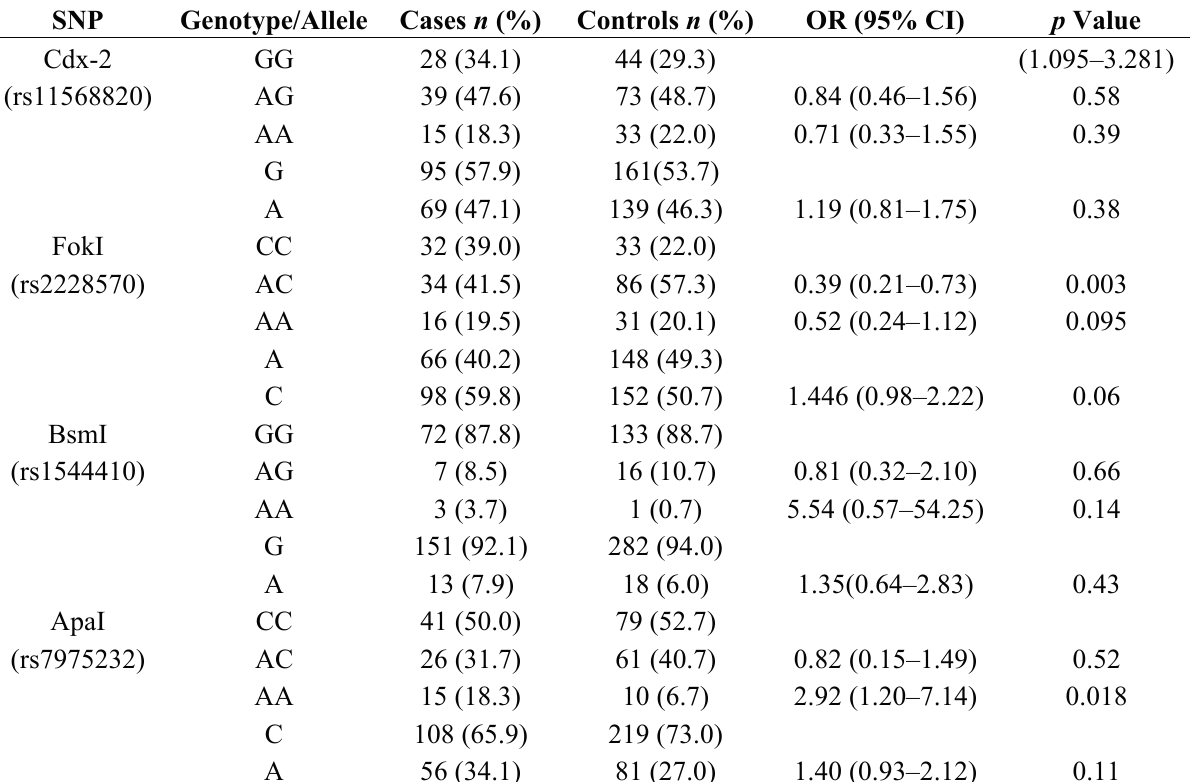
Table 2. Genotype and allele distribution of the VDR polymorphisms among cases and controls and the association with the risk of